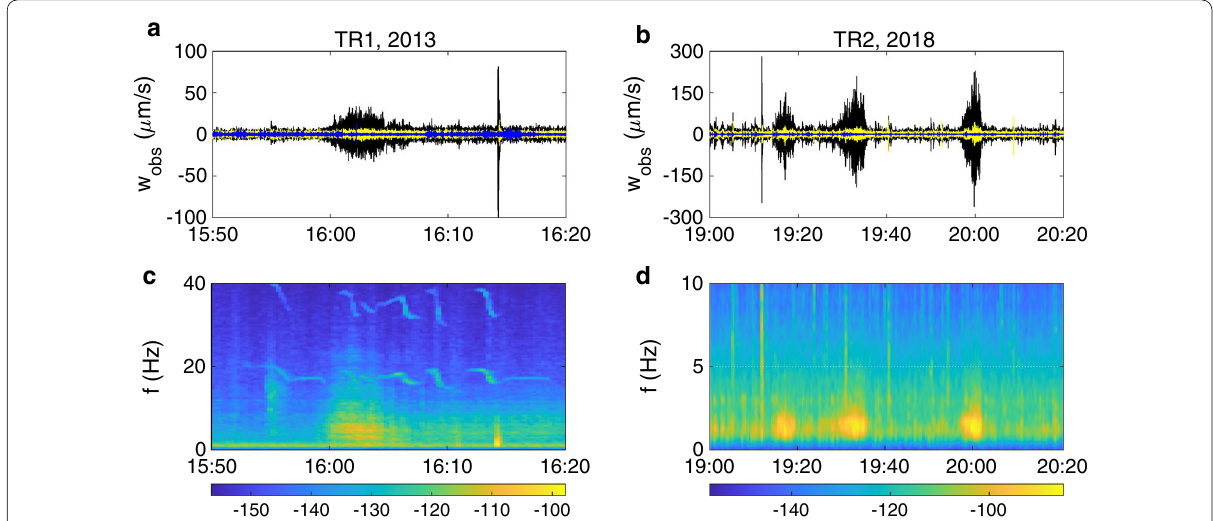
Fig. 2 Vertical ground velocity of TR1 on April 11, 2013, and TR2 on September 12, 2018. a , b The raw records at IOCD (black), IJSV (yellow), and IJTV (blue). c , d The spectrograms for the data at IOCD. The color bars indicate the power in dB